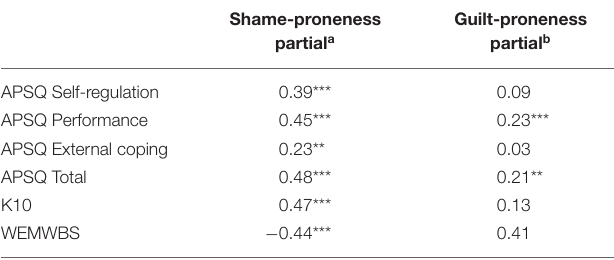
TABLE 5 | Partial correlations (Spearman) for APPS Shame- and